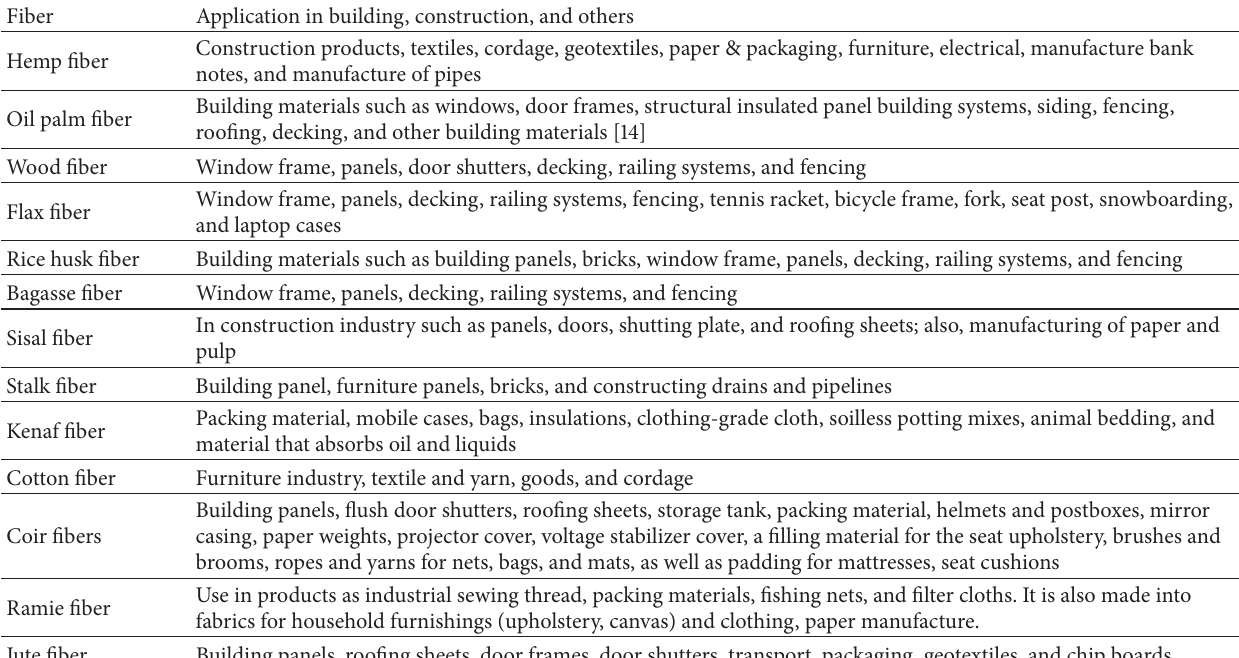
Table 6: Natural fiber composite applications in industry [3, 63–65].